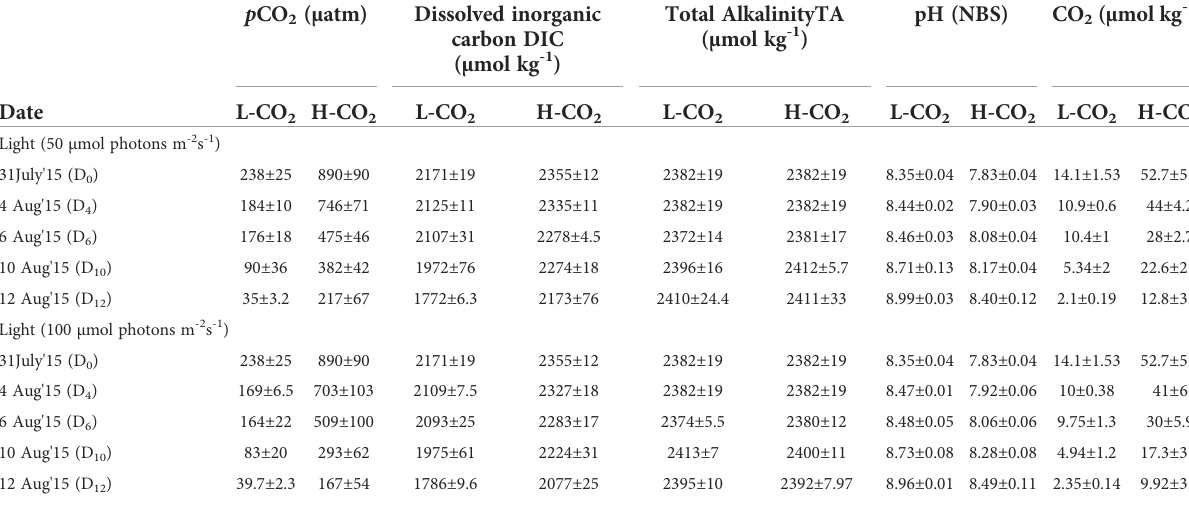
TABLE 1 Initial and fi nal carbon chemistry parameters (n =3-10) calculated using CO2SYS (Pierrot et al., 2006) over the experimental period (considering salinity 31.62 ± 0.08; dissolved silicate and phosphate levels were 85 µM ± 3.7, 4.50 ± 0.08 µM, respectively, average temperature 2.07 ± 1.3 (n=2684) was recorded over the experimental